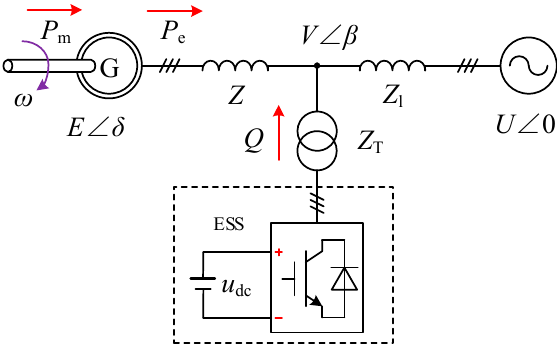
Figure 1. Equivalent model of synchronous generator (SG)-dominated power system with an energy storage system (ESS).